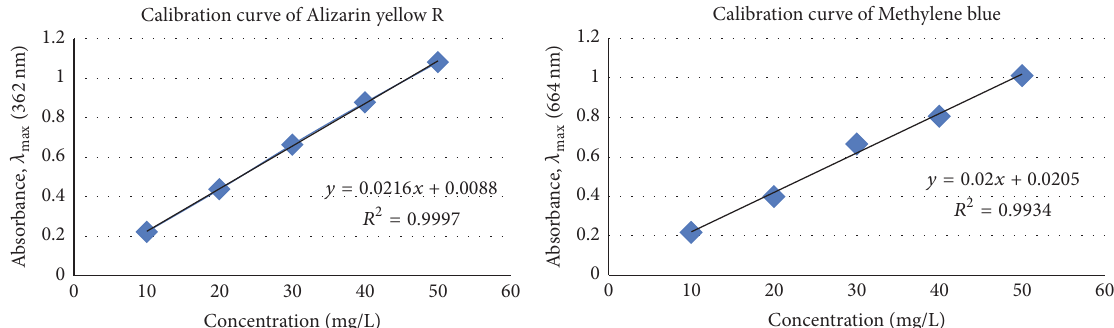
Figure 1: Calibration curves of Alizarin yellow and Methylene blue at different concentrations (10–50)mg/L.